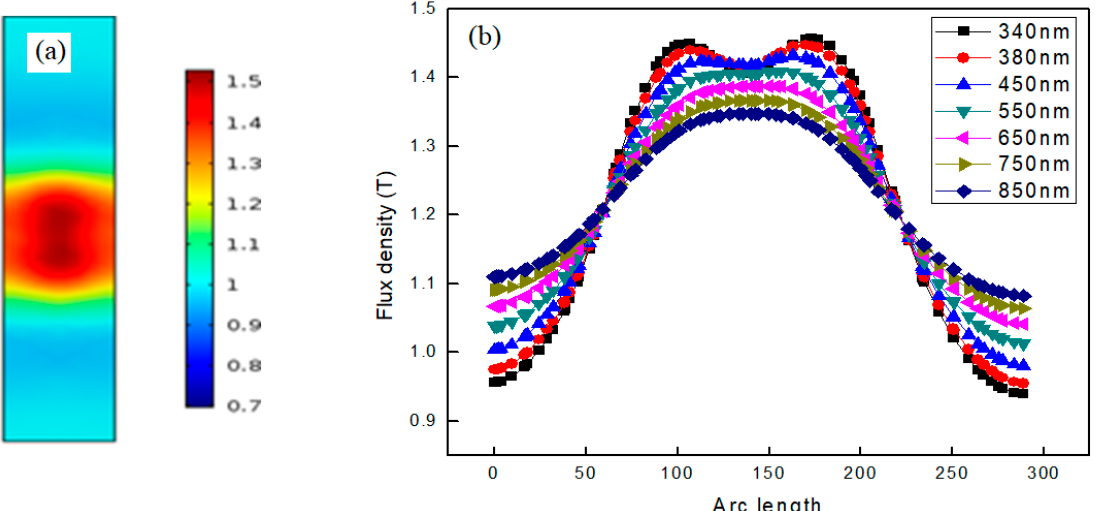
Figure 4. ( a ) Plasmon dimmer when two GaN nanowires were placed closely to show coupling of the plasmons. The color bar shows the flux density at different position in the region. ( b ) The flux density versus arc length for light incident at different wavelengths in case of uncoupled